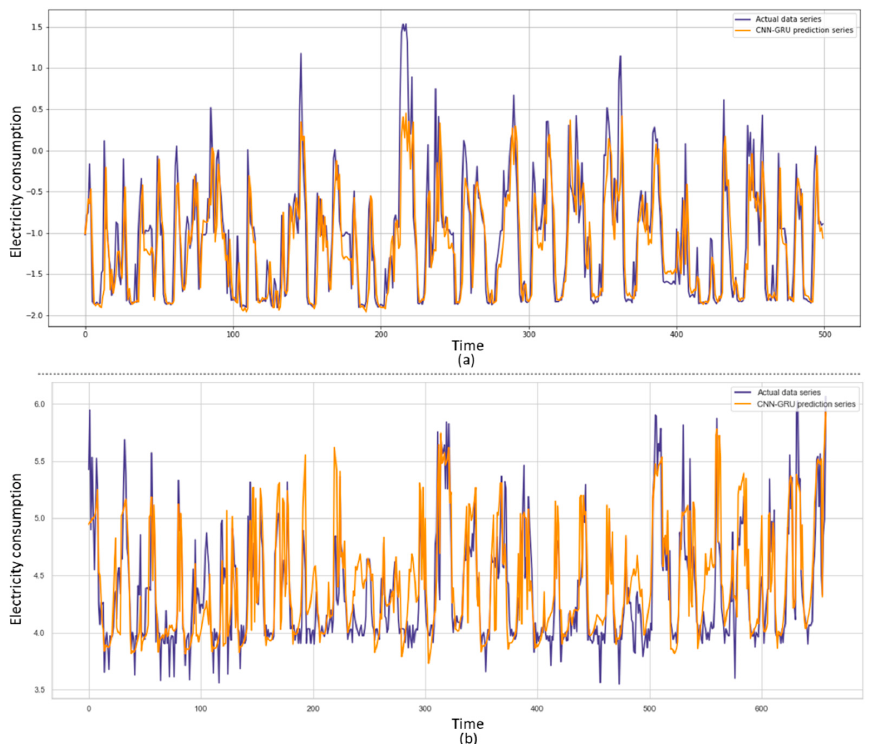
Figure 2. Predictions results of our framework over test data ( a ) actual and predicted values for IHEPC dataset ( b ) actual and predicted values for AEP dataset.